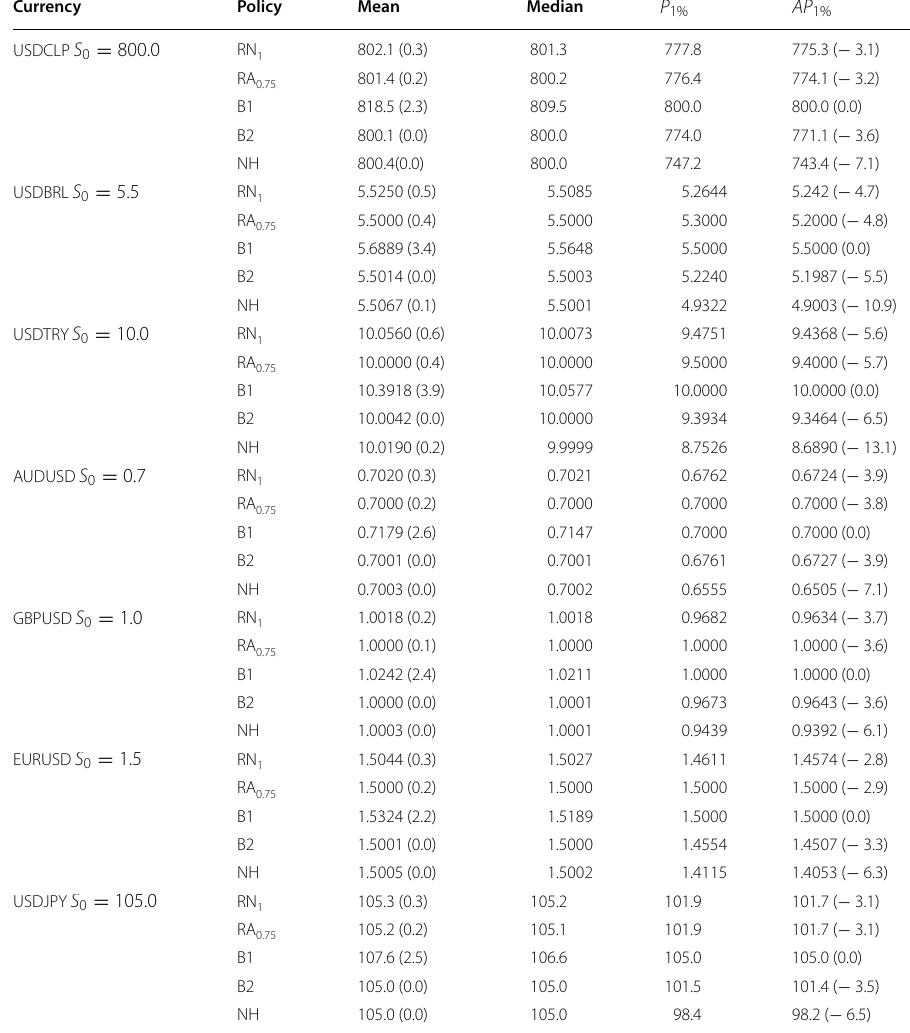
Table 6 Weighted‑average selling price of CTP solutions (RN and RA) versus benchmark policies B1, B2 and